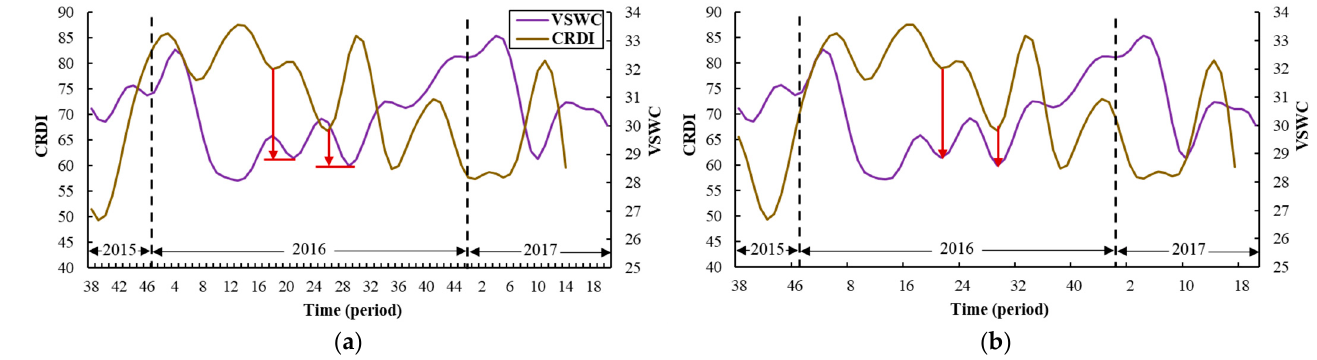
Figure 4. The indexes of CRDI and VSWC ( a ) and the indexes of CRDI and VSWC lagging 3 periods ( b ) of Guangdong. The dotted line represents the division of years.